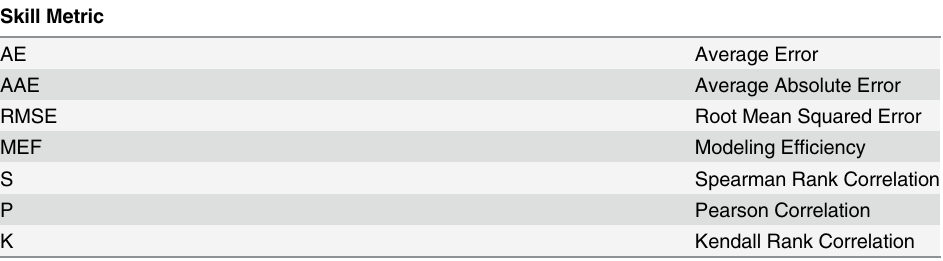
Table 3. Skill metrics used in the analysis of ecosystem model